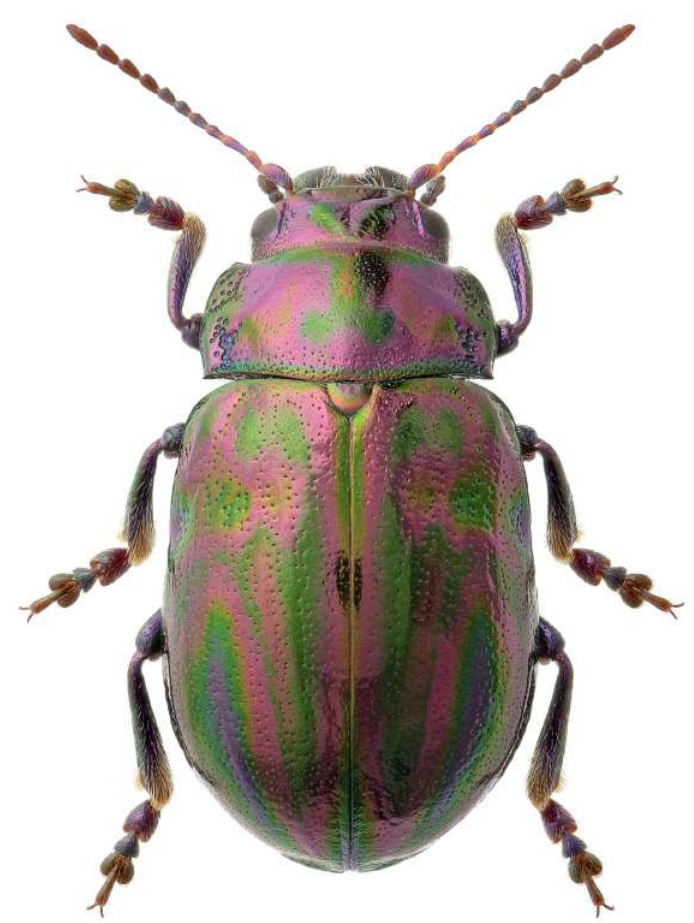
Figure 2. Ambrostoma superbum from Novosibirsk, male, dorsal